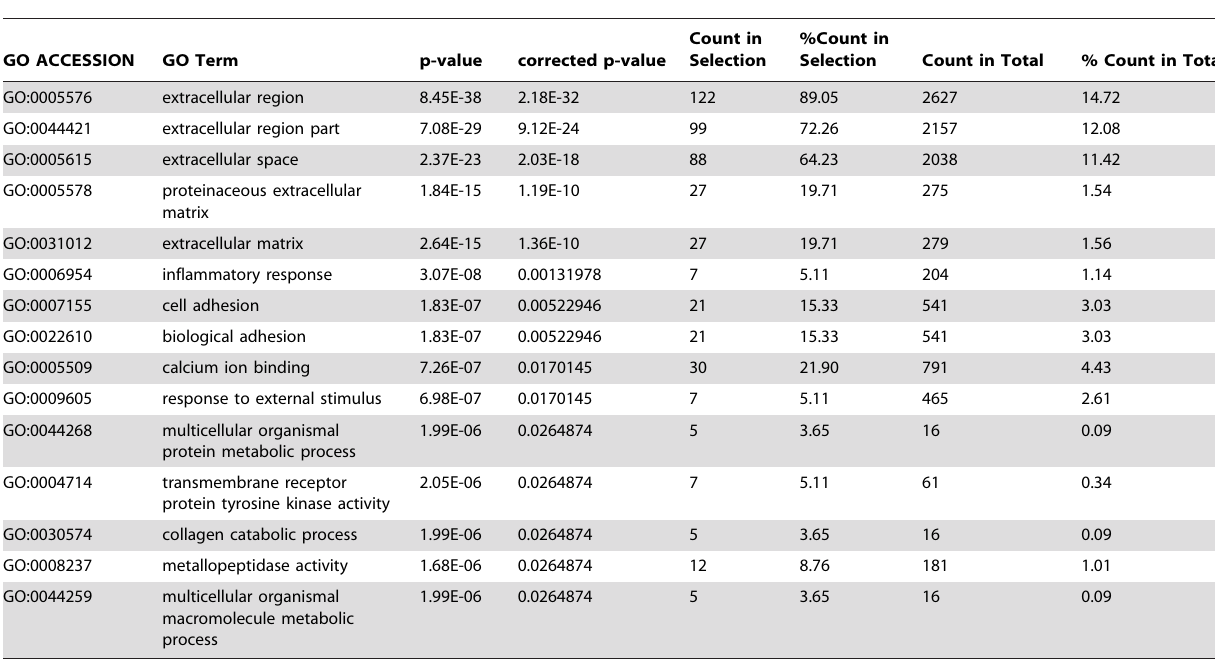
Table 8. GO Analysis of the bona fide Mta1 regulated genes in the absence of P53 with $ 2.0 fold change.